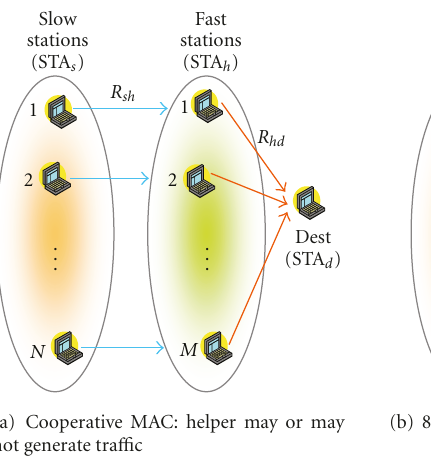
Figure 5: Experimentation topology.